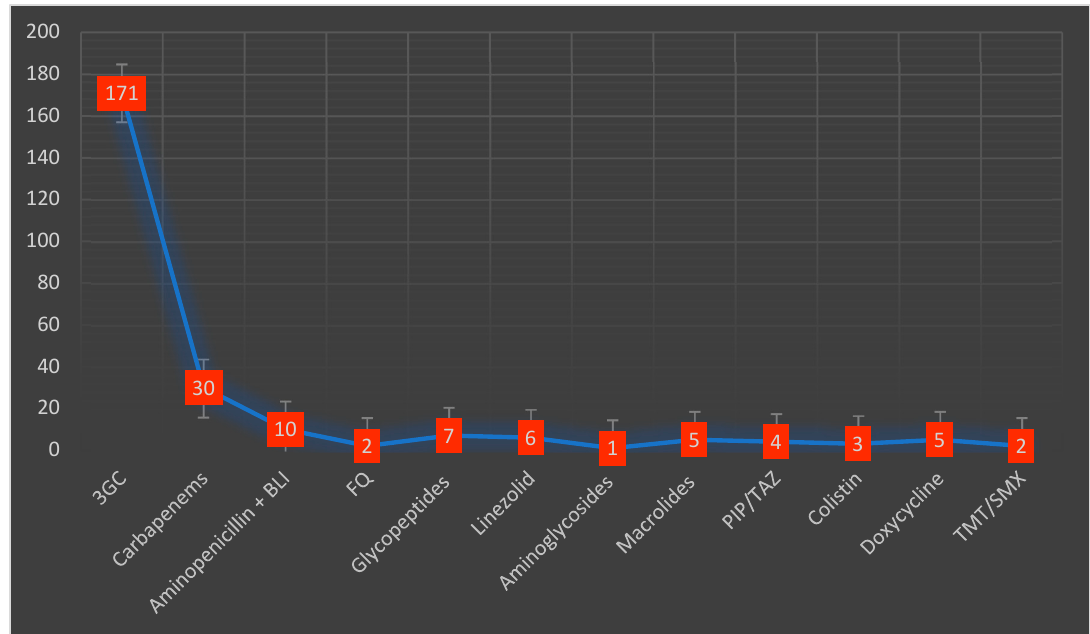
Figure 2. Types and distribution of antibiotics administered during the hospital stay. 3GC—third-generation cephalosporins, BLI—beta-lactamase inhibitors, FQ—fluoroquinolones, PIP/TAZ—piperacillin/tazobactam, TMT/SMX—trimethoprim/sulfamethoxazole. Table 3. Associated therapeutic regimens.